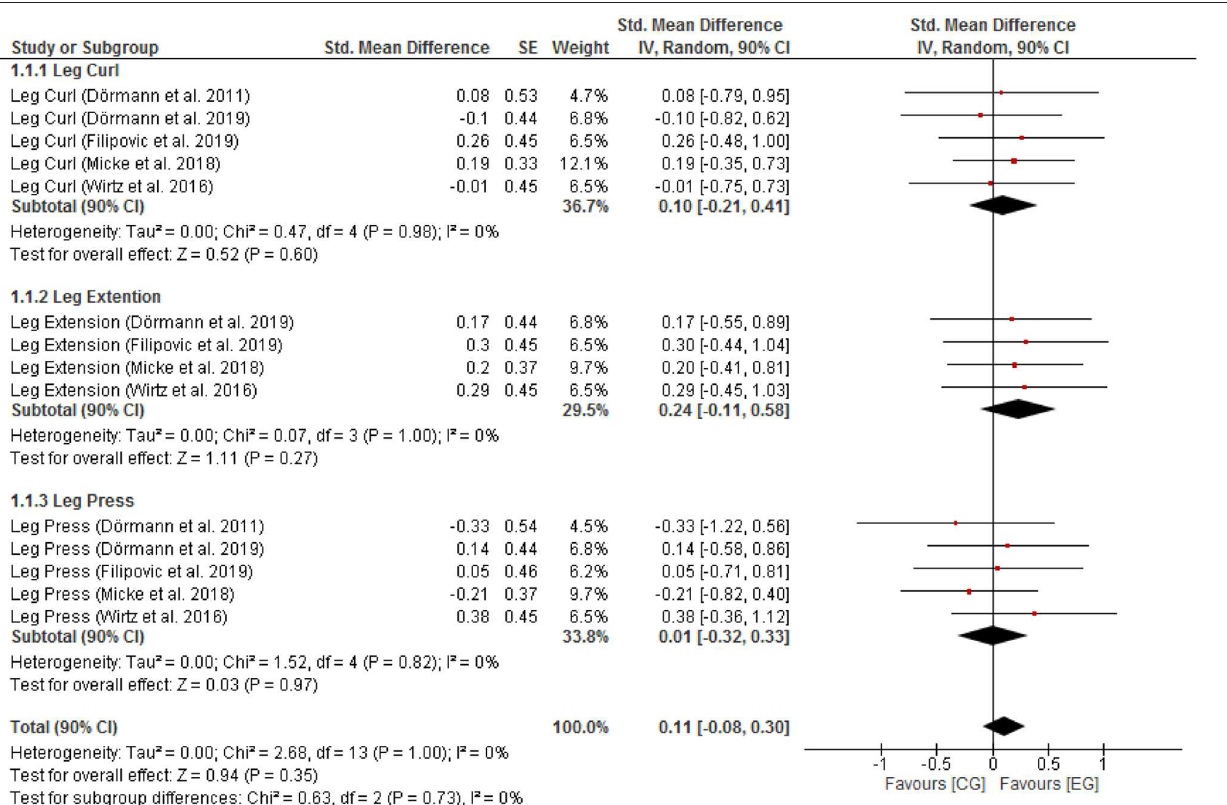
FIGURE 1 | Fmax for CG vs. EG. SE, standard error; CI, confidence interval; Std., standardized; IV, independent variable.